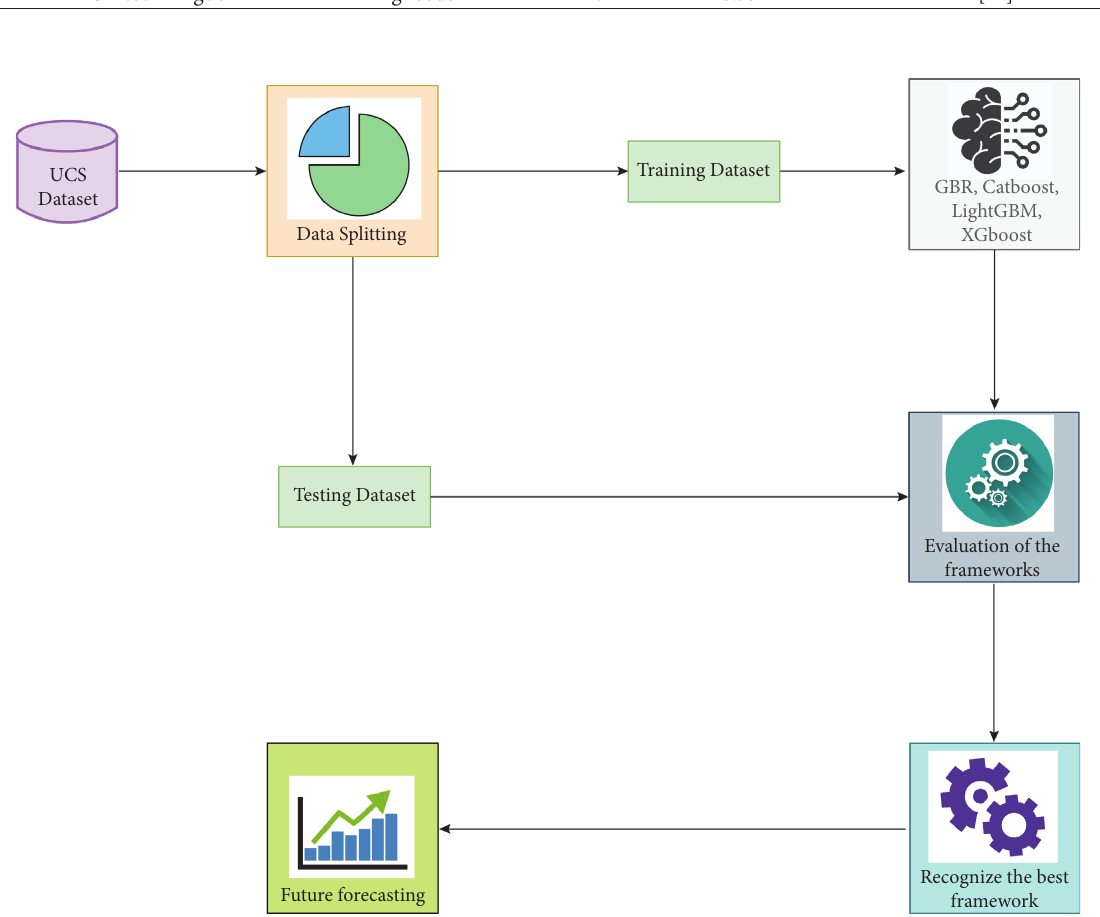
Figure 1: Flowchart of the study.